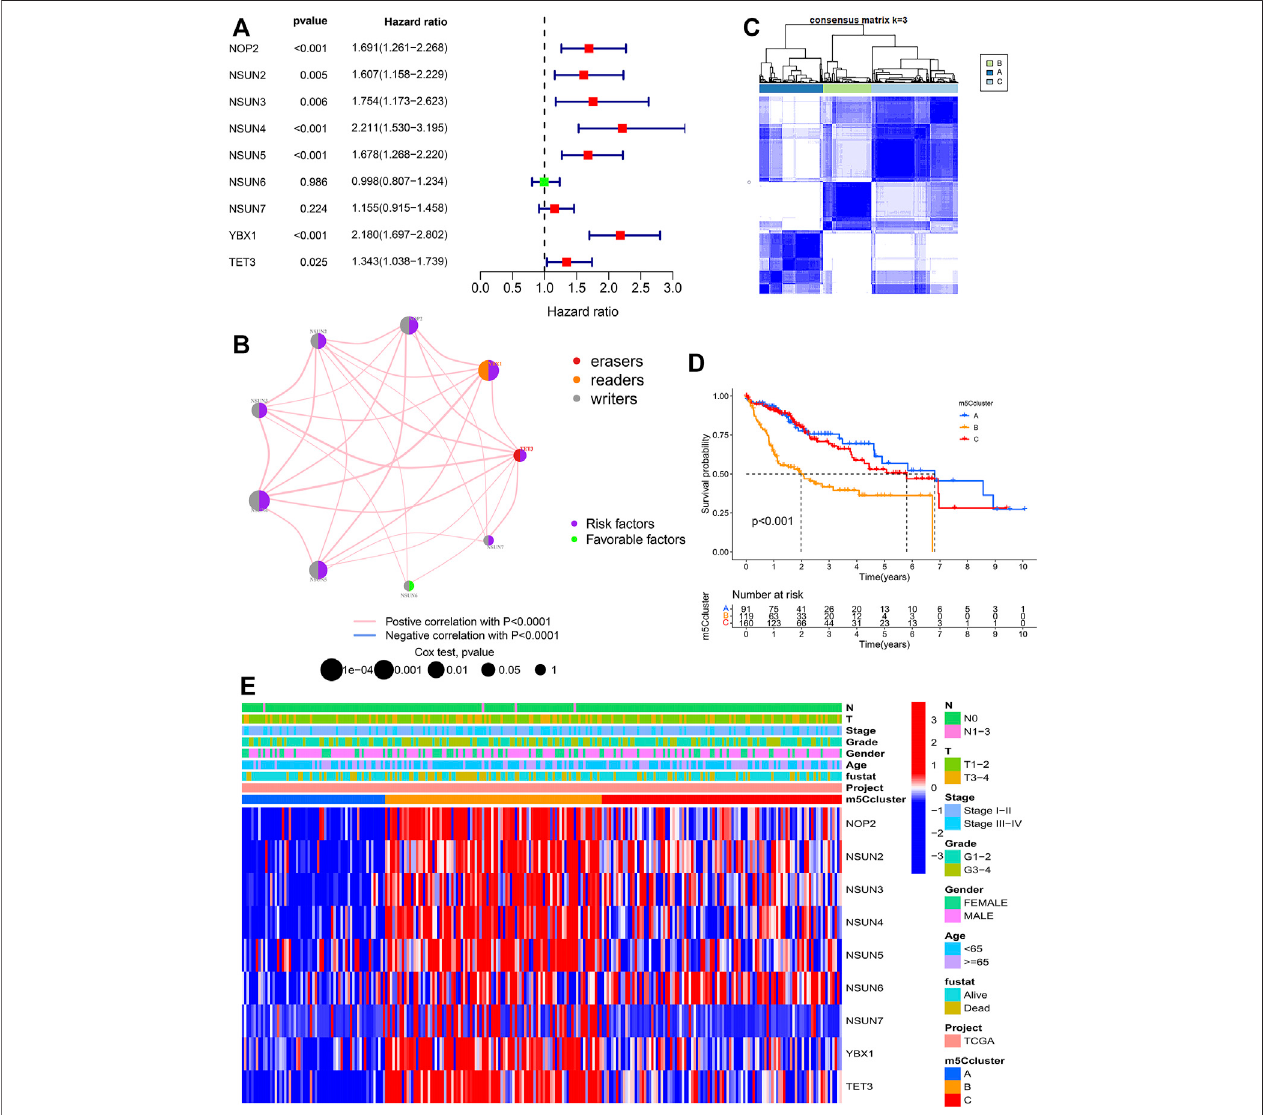
FIGURE 3 | Molecular characteristics of m5Cclusters. (A) Forest plot of univariate Cox regression analysis results; (B) Interaction of m5C regulators in HCC; (C) Consensus clustering matrix for k = 3; (D) Survival analysis of patients in distinct m5Cclusters; (E) Heatmap depicting the expression levels of m5C regulators in distinct